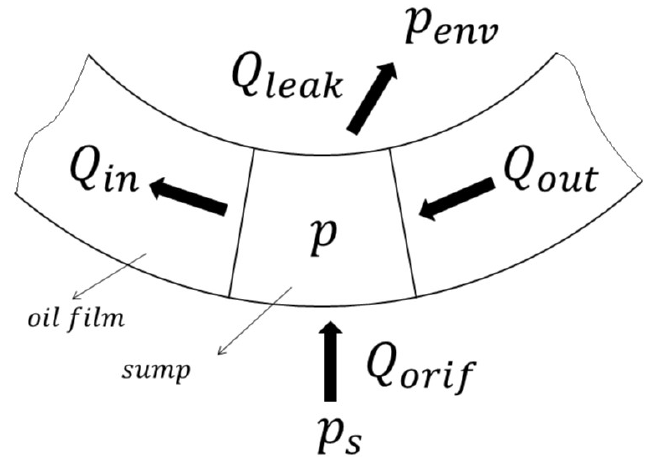
Figure 4. Scheme of the sump interposed between two adjacent